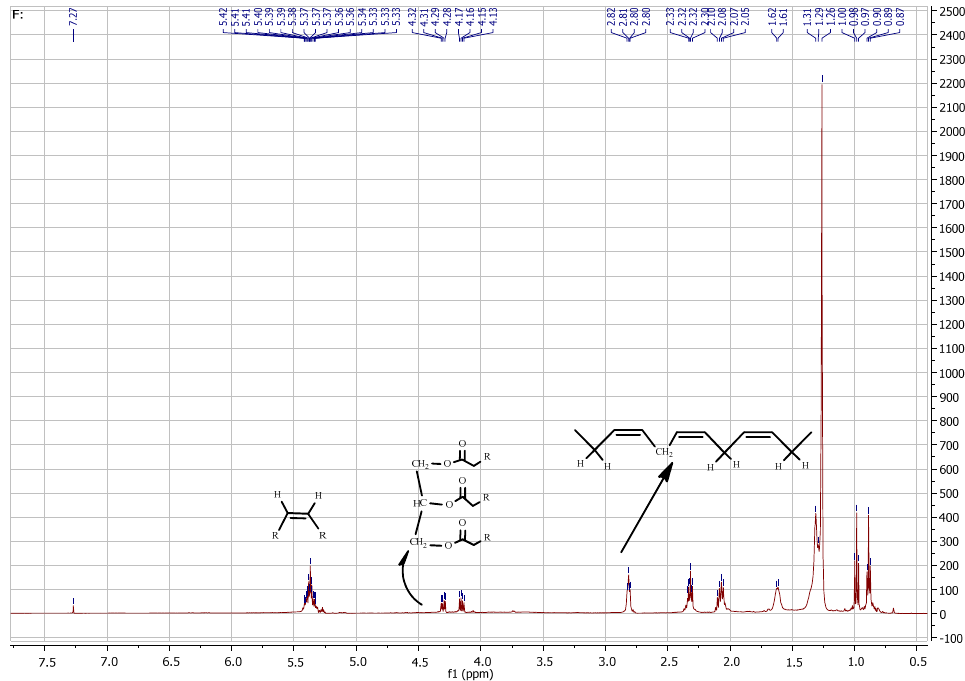
Figure 2. The 1 H-NMR spectrum of the crude gorse flowers extracted with DCM.